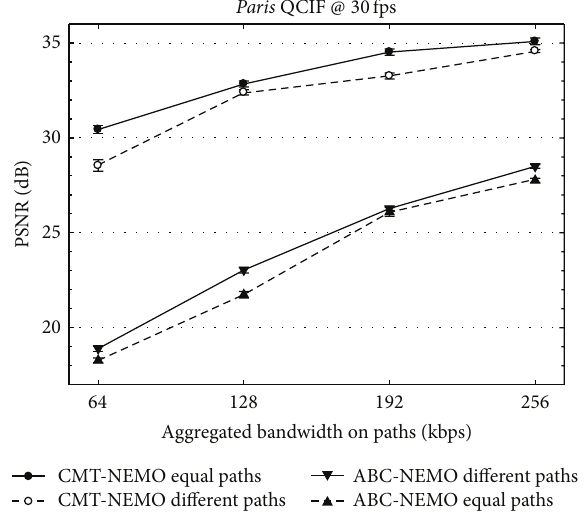
Figure 14: Comparison using the Paris sequence at low bandwidths.